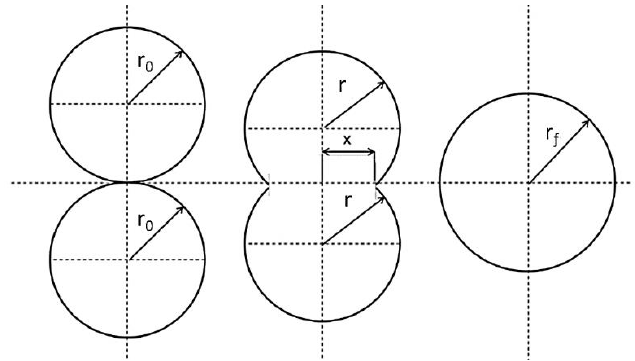
Figure 1. Schematic of sintering of two spherical particles. Redraw from reference [7].